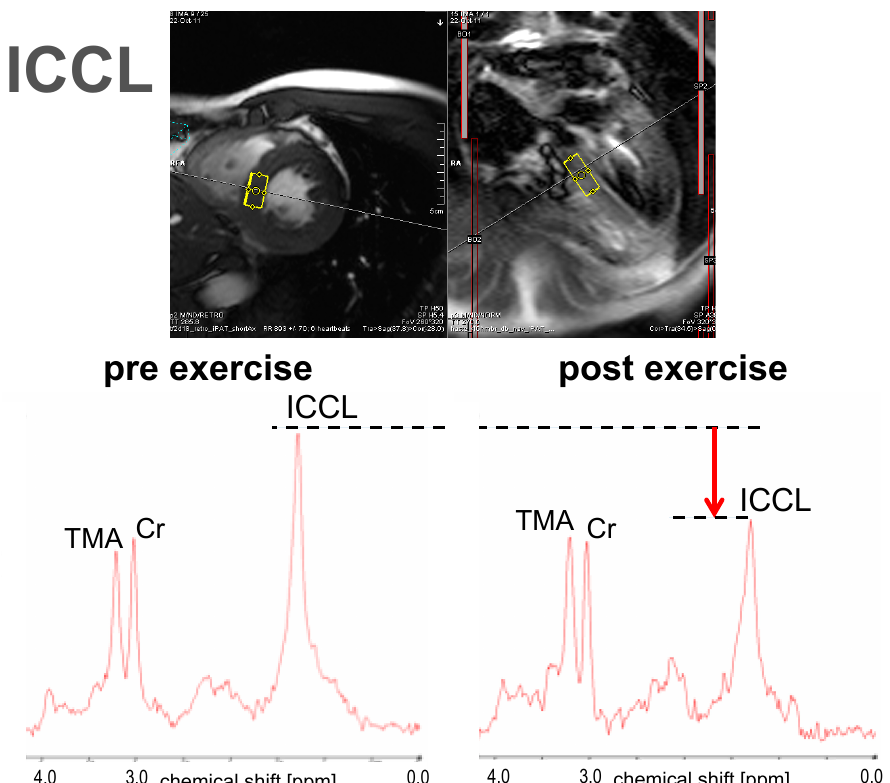
Figure 3. Sample 1 H-MR spectra for the quantification of ICCL obtained before and after an exercise bout of 2 h: The largest peak in the pre-exercise spectrum originates from the aliphatic methylene groups in the fatty acid chains of ICCL. Direct comparison of the pre- and post-exercise spectra shows that ICCL were consumed during/after the exercise. Other peaks originate from further protons on the ICCL lipid chains, and creatines (CH 2 at 3.9 ppm and CH 3 at 3.0 ppm) and trimethyl-ammonium (TMA) groups from metabolites, like carnitine, or the phosphocholines. (For details of the acquisition methods, see [43]; in short: single volume (~5 cm 3 ), double spin echo localization, echo time 35 ms, 3T, spectra obtained in sync with respiration and the cardiac cycle, triggered for acquisition in both expiration (based on realtime MR-images) and in end-systole (derived from the ECG signal)). The spin-echo images above the spectra that had also been obtained with double triggering and in the same respiratory and cardiac phase show the typical location where the spectra were obtained.